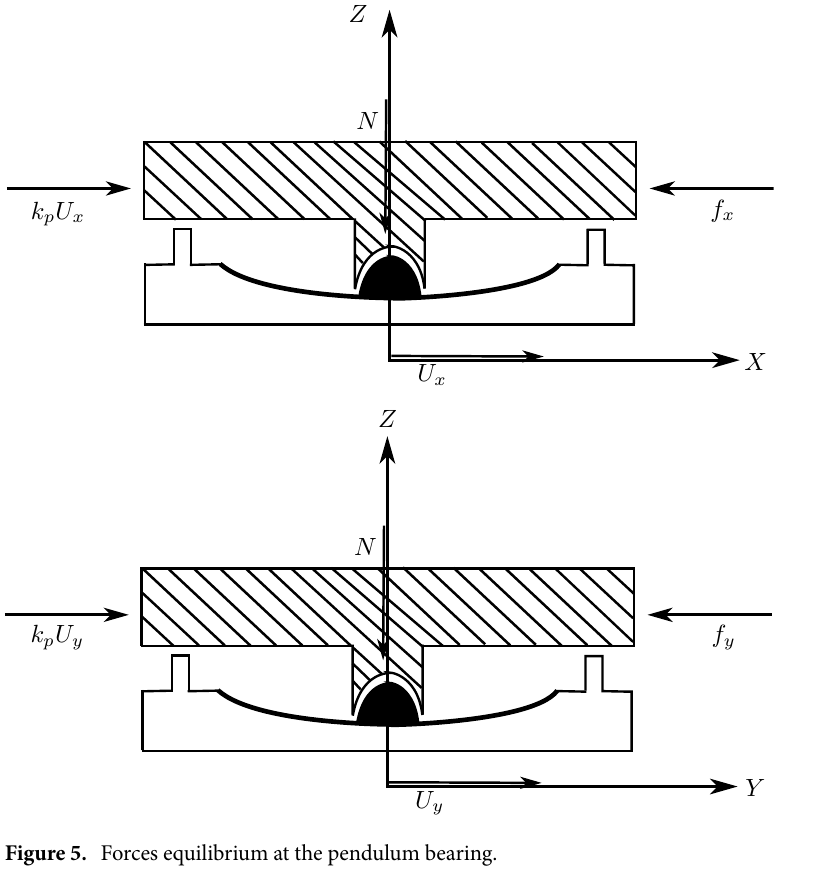
Figure 5. Forces equilibrium at the pendulum bearing.